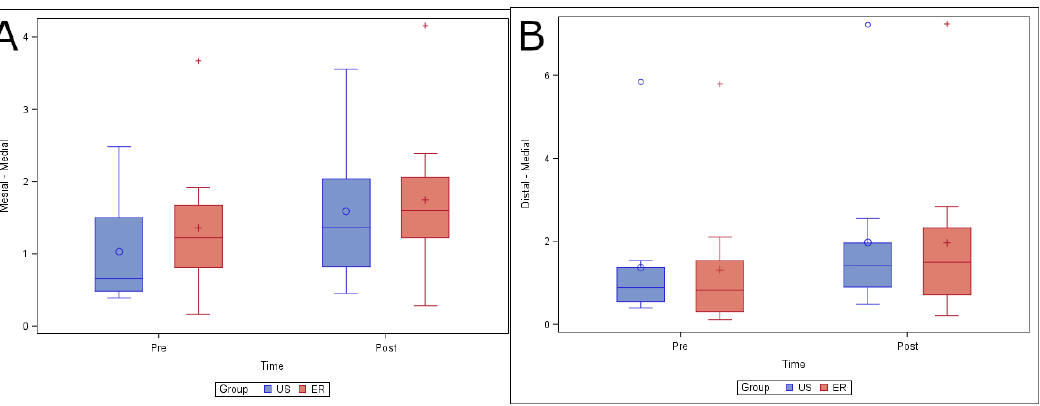
Figure 5. ( A ) Box plot of volume of dentin removed preoperatively and postoperatively, comparing the US and ER study groups at the medial level in the mesiobuccal and ( B ) distal root canal systems. Finally, no statistically significant differences ( p = 0.5990) were found in changes in volume at the apical root third between the US (0.43 ± 0.35 mm 3 ) and ER (0.50 ± 0.30 mm 3 ) study groups in the mesiobuccal root canal system. In addition, there were no statistically significant differences ( p = 0.6592) in the change in volume between the US (0.53 ± 0.44 mm 3 ) and ER (0.45 ± 0.27 mm 3 ) study groups in the distal root canal system (Figure 6). The time it took to remove the NiTi alloy endodontic rotary files randomly assigned to the ER study group ranged between 9–25 min, and 18–90 min for the files assigned to the US group. Finally, the relationship between the dentin removal and the working time of the removal systems was also analyzed; however, no statistically significant differences were shown at the messiobuccal root canal system ( p = 0.0252) (Figure 7A) neither the distal root canal system ( p = 0.0116) (Figure